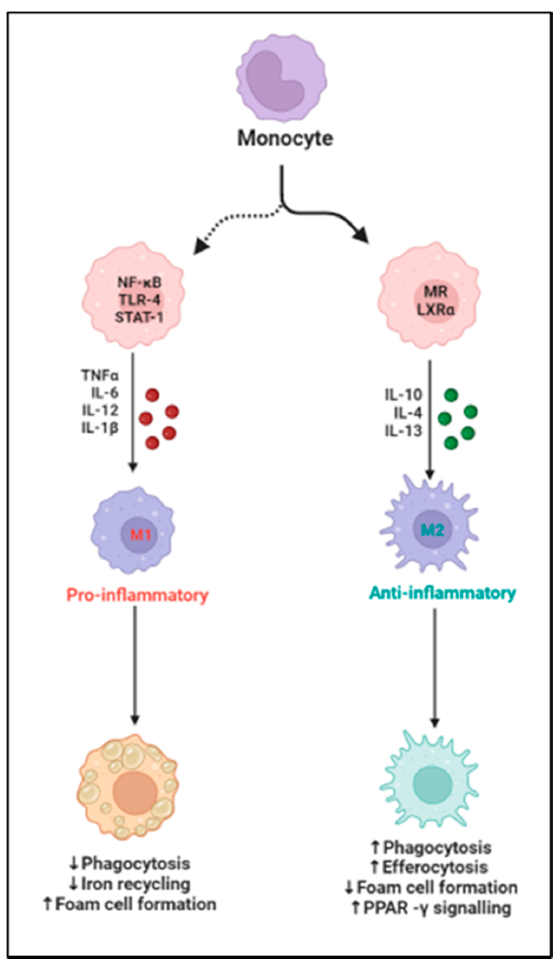
Figure 4. Schematic illustrating macrophage polarization to proinflammatory M1 and to an anti- inflammatory M2 phenotype and the specific factors affecting the process, up arrows mean increased levels, and down arrows refer to decreased